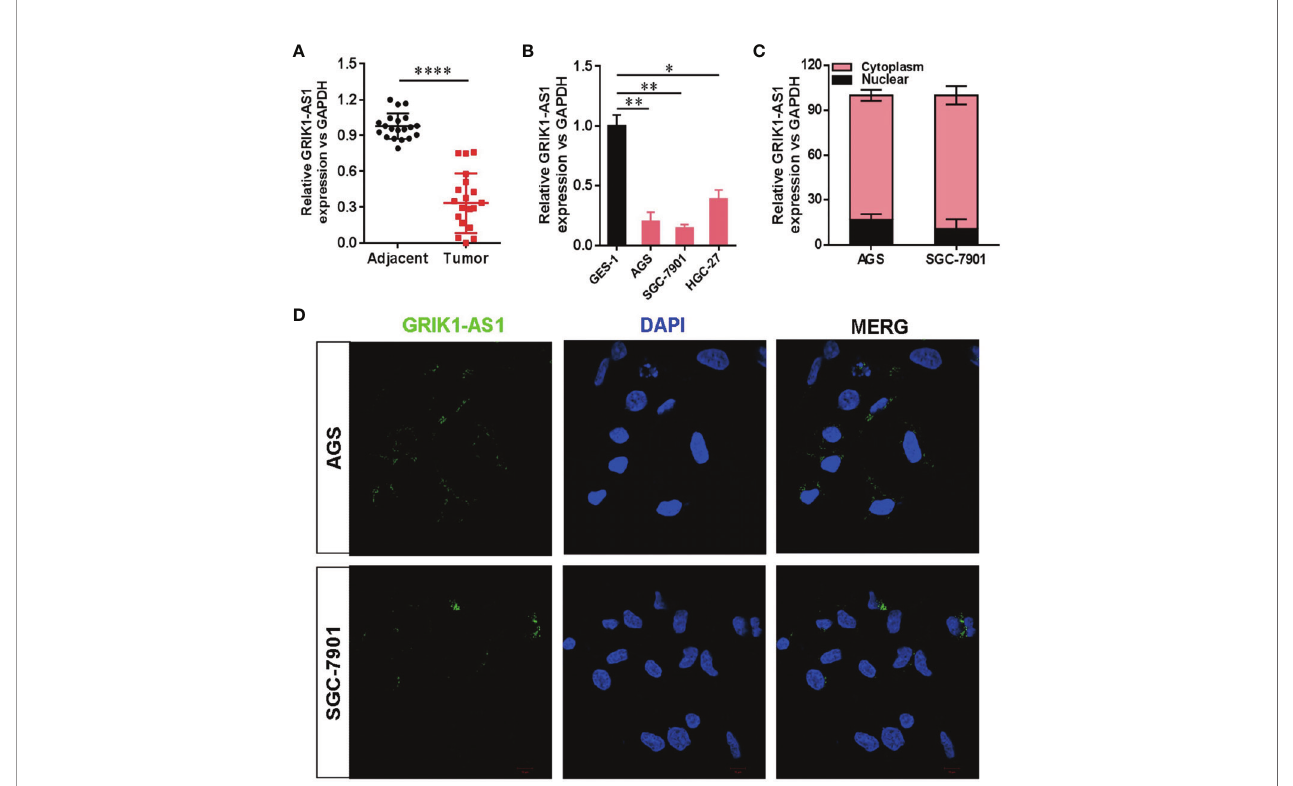
FIGURE 1 | Decreased LncRNA GRIK1-AS1 expression in gastric cancer. (A) . Real-time qPCR analysis of GRIK1-AS1 expression in gastric cancer tissues and adjacent normal tissues. (B) . Real-time qPCR analysis of GRIK1-AS1 expression in gastric epithelial cell GES-1 and gastric cancer cells AGS, SGC-7901 and HGC-27. (C) . The sub-cellular localization of GRIK1-AS1 in gastric cancer cells (AGS and SGC-7901) was determined by the nuclear/cytoplasm distribution analyses and RNA- FISH assays. (D) . Fluorescence in situ hybridization (FISH) analysis indicates the cytoplasmic localization of GRIK1-AS1 in AGS and SGC-7901 cells. * P < 0.05, ** P < 0.01, **** P <